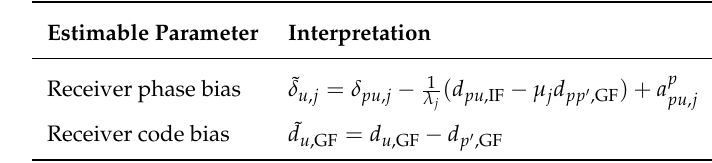
Table 2. Changes in parameter estimability and interpretation in the PPP-RTK user model due to the introduction of external ionospheric